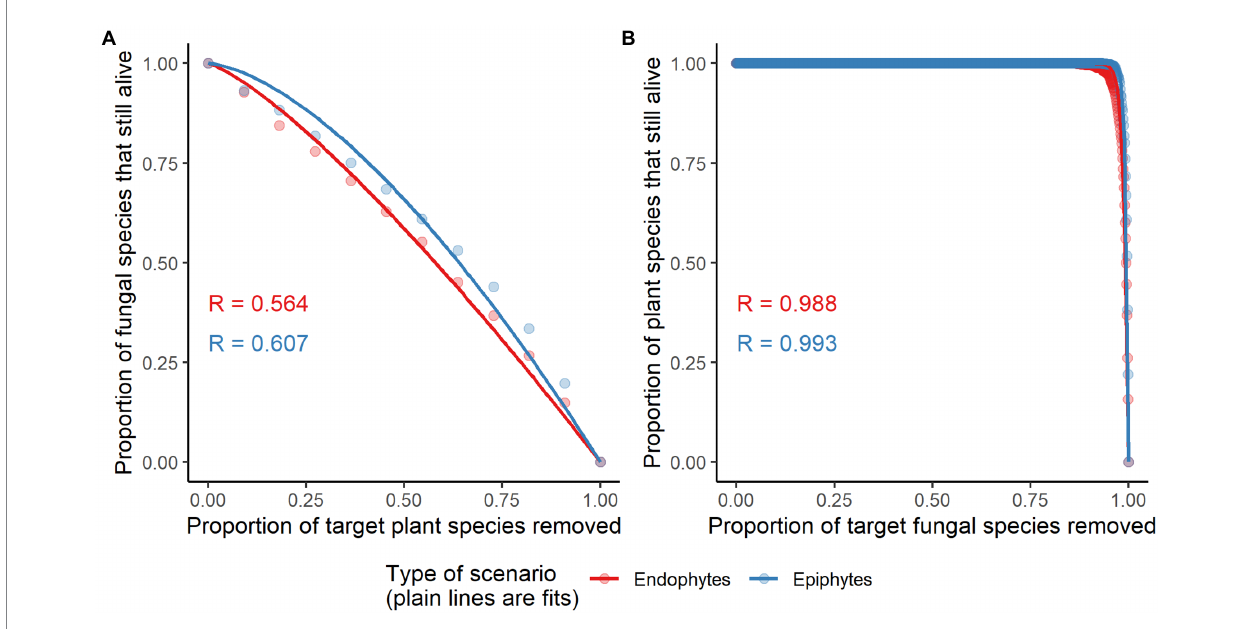
FIGURE 6 Network robustness of plant-endophytic fungi and plant-epiphytic fungi. The secondary extinctions of epiphytic and endophytic fungal species to random extinctions of host plant species are shown in panel (A) . The secondary extinctions of plant species to random extinctions of epiphytic and endophytic fungal species are shown in panel (B) . The area below the curve (representing network robustness, R ) was used to quantify the tolerance of a system to the extinction of its component species. R values of network robustness are shown in each